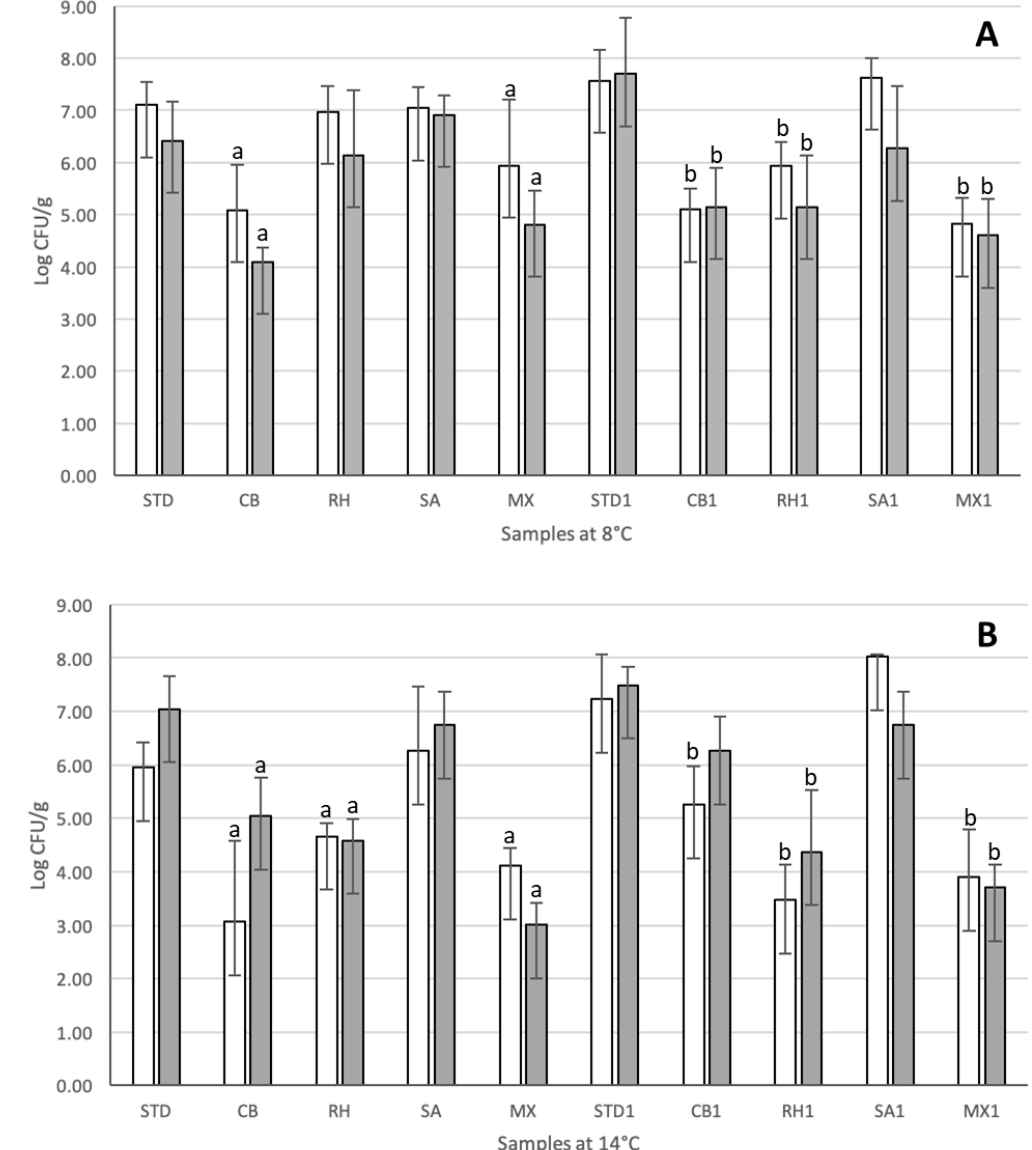
Figure 2. Viable counts on VRBA (white bars) and Pseudomonas Agar (grey bars) of cheese stored at 8 ◦ C ( A ) and 14 ◦ C ( B ). STD: control; CB: C. maltaromaticum CNB06; RH: Lcb. rhamnosus RH05; SA: Llb. sakei LSK04, MX: mix of the three adjunct strains. The number 1 after the culture code indicates the strains intentionally spiked with spoilage bacteria. Error bars indicate the standard deviations and letters above the bars indicate the significant di ff erence of treatments (n = 3 and p < 0.05) when compared to the relevant controls (a in non-spiked samples and b in artificially contaminated